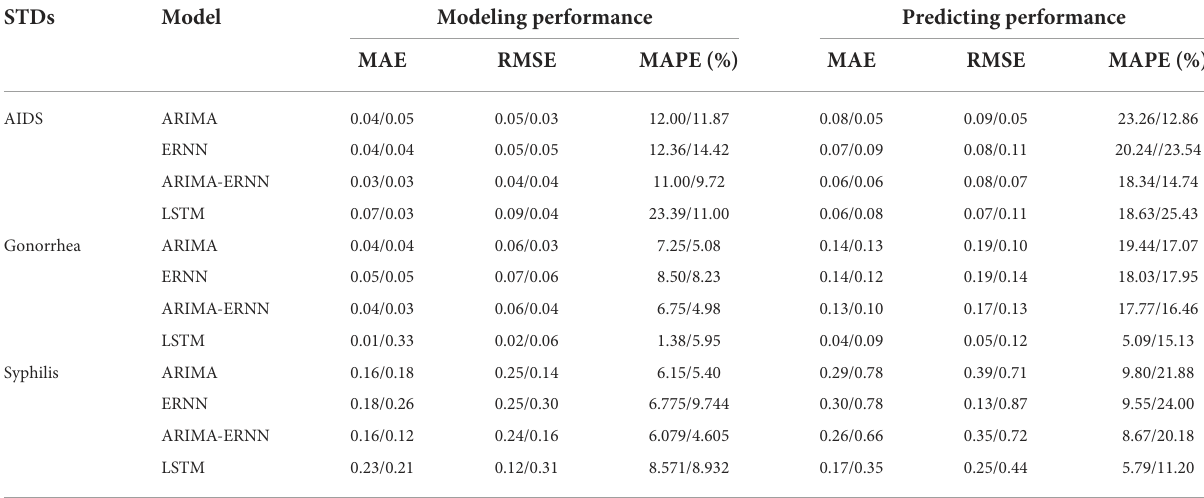
TABLE 3 Comparison of the performances of the four different models a . STDs